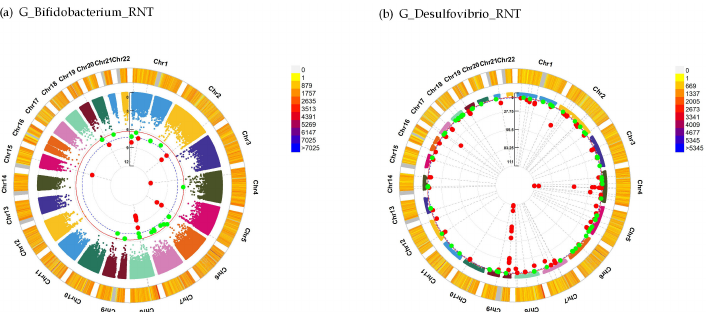
Figure 1. Interaction analysis between SNP and gut microbiota for neuroticism. Chromosomal regions interacting with G_ Bifidobacterium _RNT ( a ) and G_ Desulfovibrio _RNT ( b ) for neuroticism. From the center, the first circos depicts the − log 10 P of each variant owing to double exposure, i.e., the effect of both single nucleotide polymorphism allele and gut microbiota. The second circos shows chromosome density. Red plots indicate the P -value threshold for genome-wide significance ( P < 5 × 10 − 8 ), while the green plots indicate the P -value threshold for suggestive significance ( P < 5 × 10 − 7 ). The plots were generated using the “CMplot” R script (https://github.com/YinLiLin/R-CMplot (accessed on 3 April 2021)). SNP, single-nucleotide polymorphism; G, genus; RNT, rank-normal transformation. Table 3. Summary of interaction analysis between SNP and gut microbiota for general happiness.